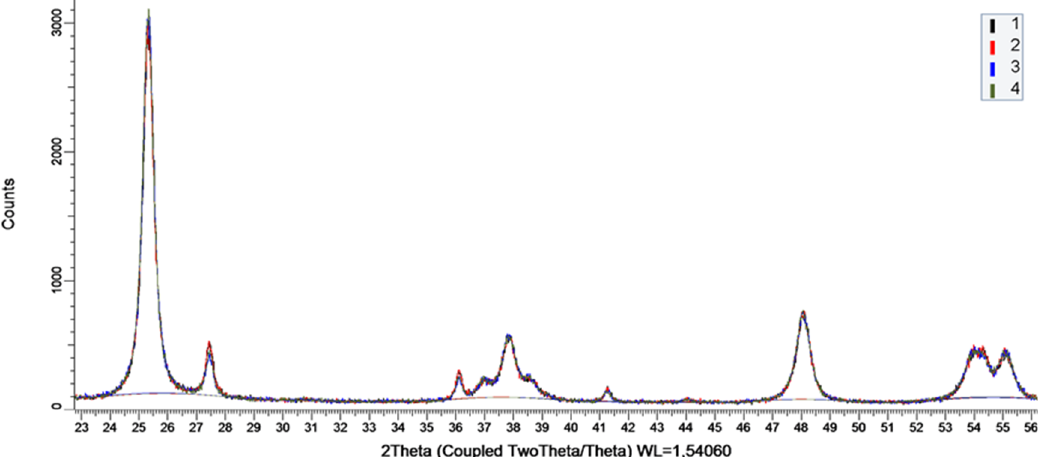
Figure 3. XRD patterns for sample numbers 1_100, 1_290, 2_100 and 2_290.